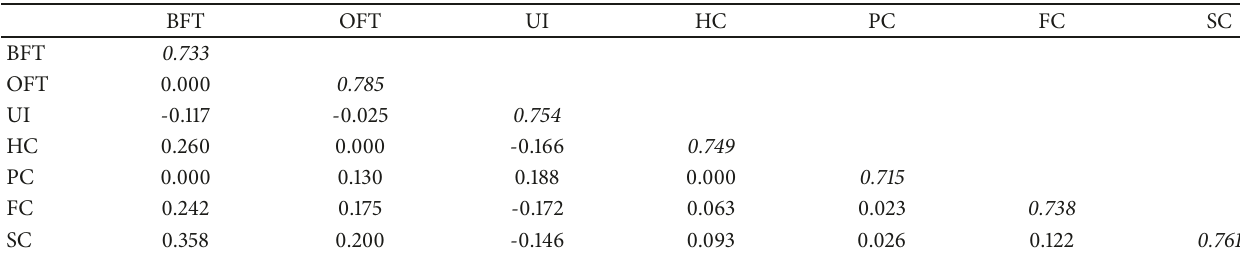
Table 5: Correlation matrix and discriminant validity